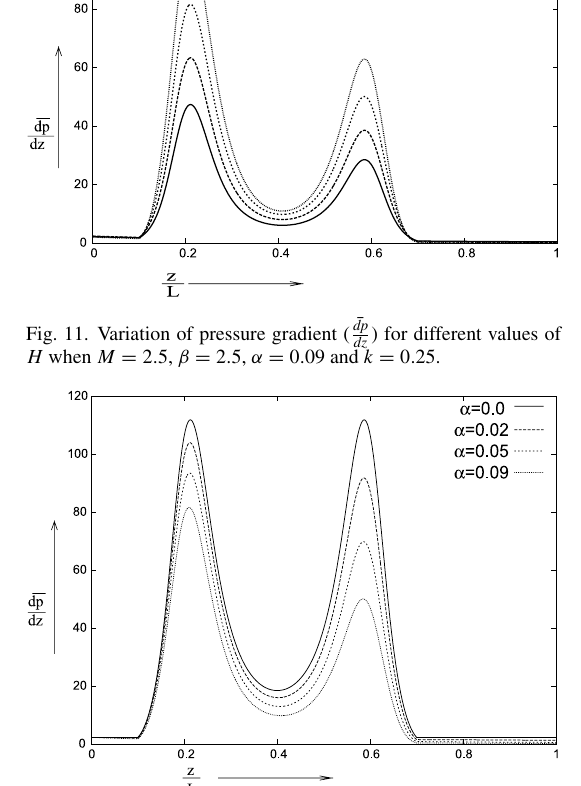
¯ dp z fordifferentvalues dz )with